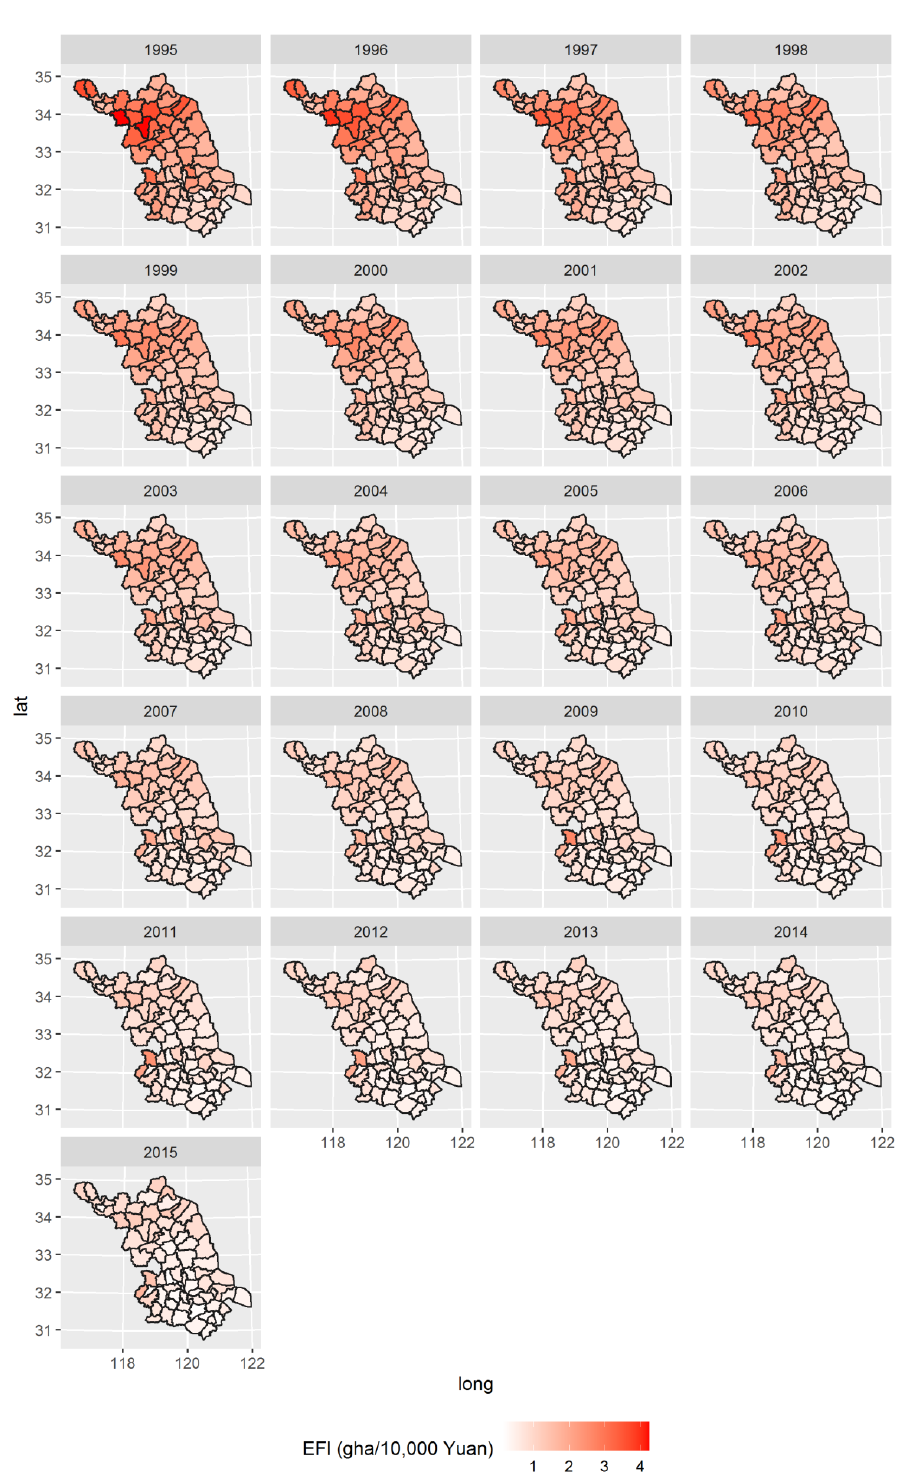
Figure 9. Spatial distribution of EFI of Jiangsu Province in 1995 – 2015.